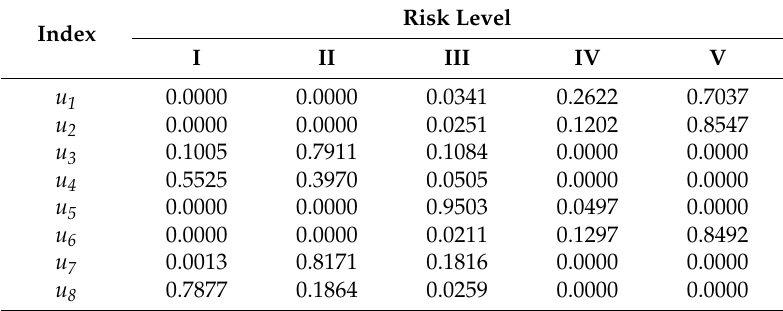
Table 21. Certainty degrees of AP of southwest Guizhou.